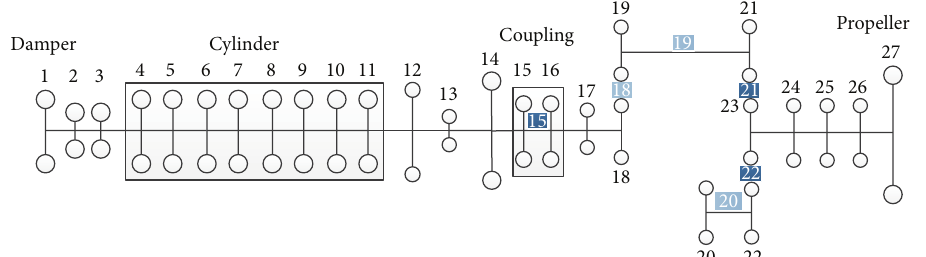
Figure 2: Lumped simplified model of a diesel propulsion shafting.